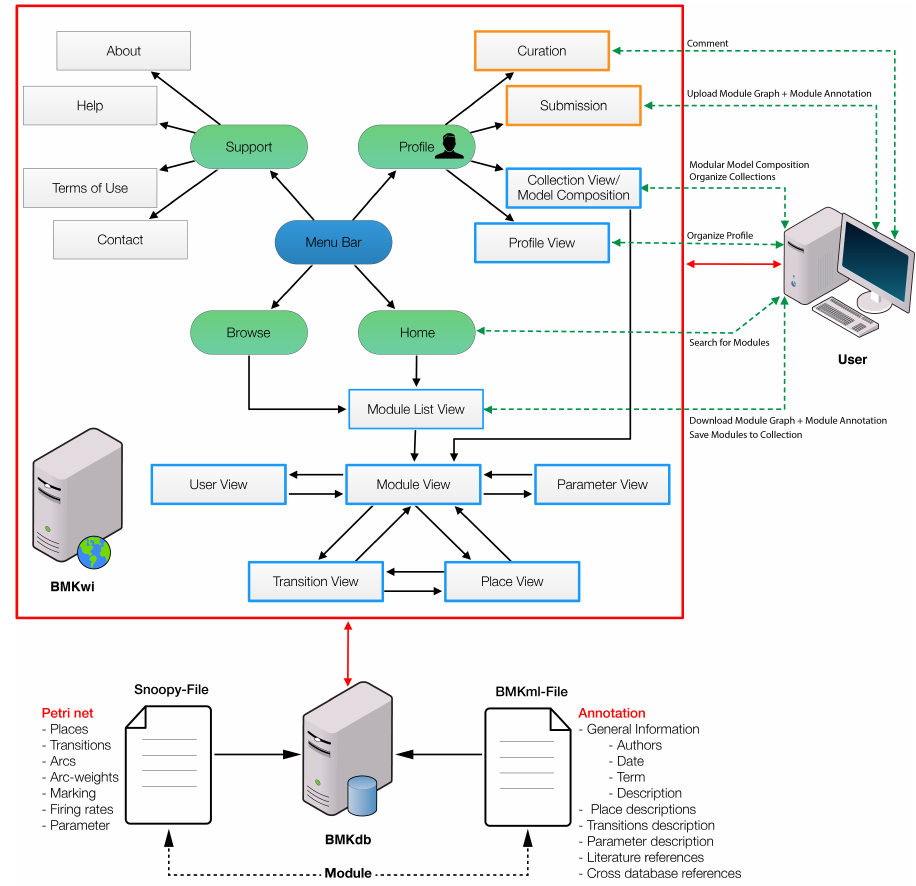
Figure 5: BioModelKit database and navigation scheme of the web-interface with features available for user